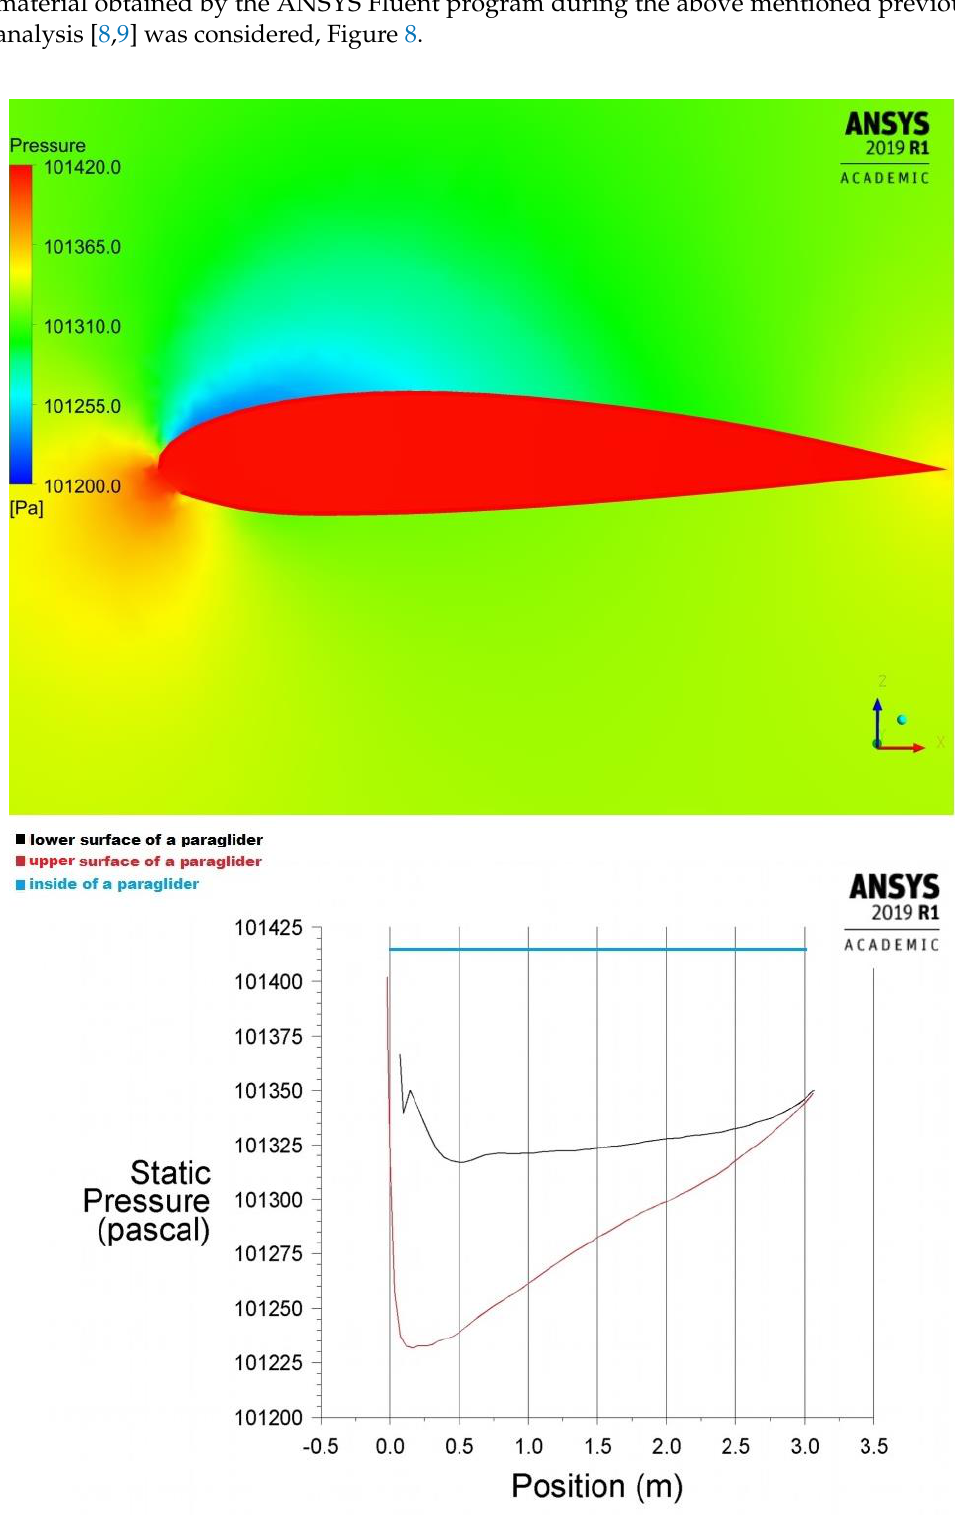
Figure 8. Pressure acting on a material during a flight of a paraglider (based on [9]). The case [9] considered undisturbed flight conditions, where the velocity of a para- glider v = 45 km/h, the angle of attack α = 6 °, the air temperature T = 300 K, and pressure p = 101,325 Pa. The air was considered as ideal gas. The pressure distribution in Figure 8 is the most advantageous due to the paraglid- er ’ s principle of flight. A suitable lifting force is only created when the internal pressure is a constant of the maximal value. The lower pressure or the disturbed distribution inside